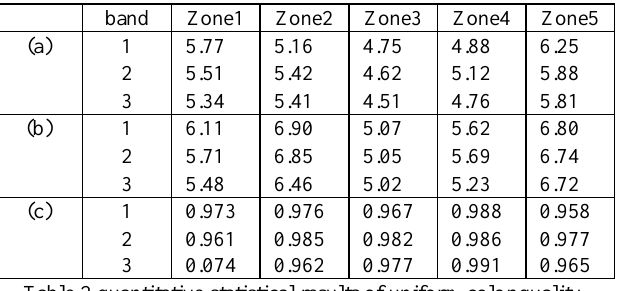
Table 2 quantitative statistical results of uniform color quality (a) Image information entropy before uniform color (b) Image information entropy after uniform color (c) Correlation coefficient between reference image and uniform color